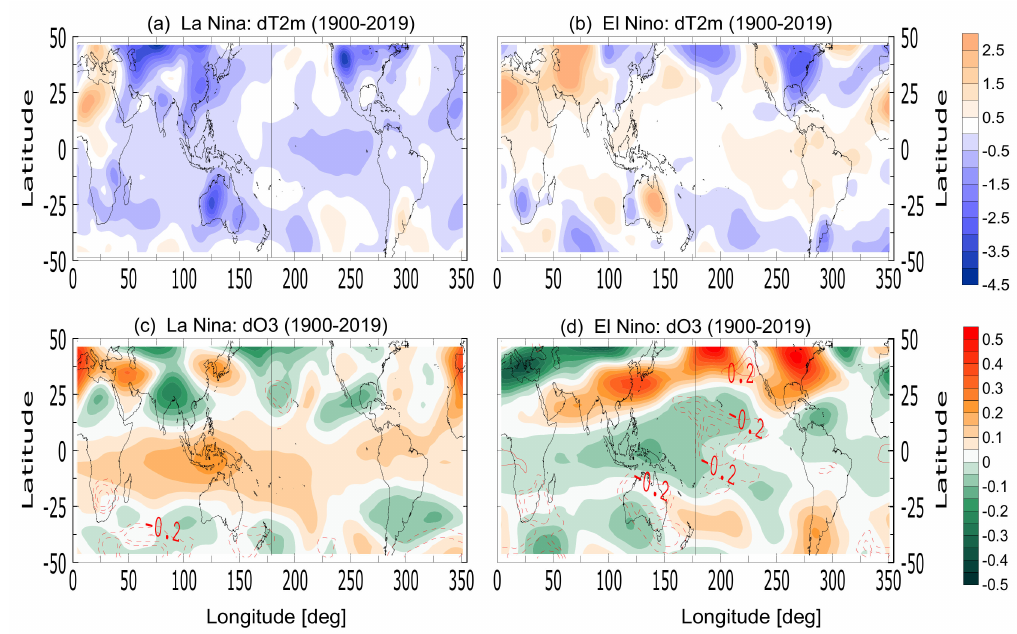
Figure 5. Spatial distribution of dynamical anomalies of air surface temperature ( a , b ) and ozone at 70 hPa ( c , d ), covering the period 1900–2019, are shown for La Niña ( a , c ) and El Niño ( b , d ) composites. The ozone–sea level pressure correlation, shown in Figure 3, (with O 3 as the leading factor), is overlaid on the maps of ozone anomalies for easier